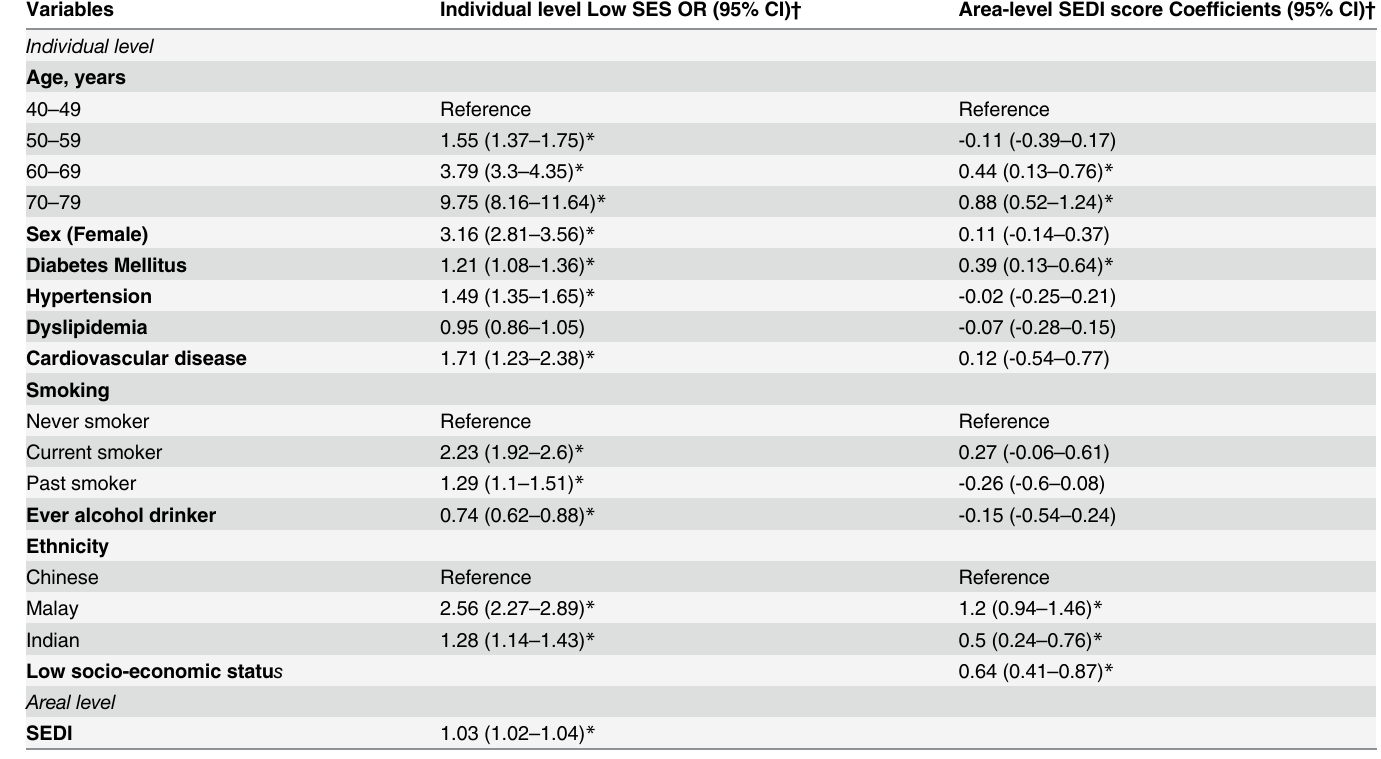
Table 2. Association of low SES and SEDI with characteristics of